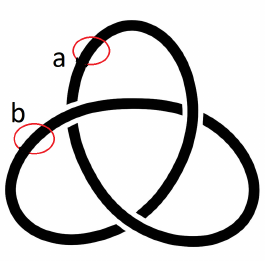
Figure 1. The simplest knot, trefoil knot 3 1 .